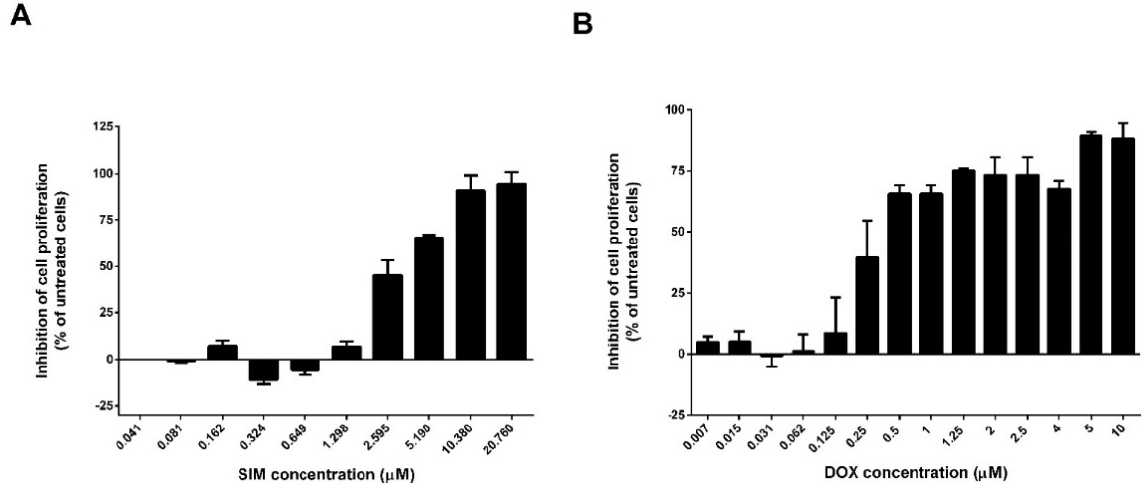
Figure 9. The effects of SIM and DOX on the proliferation of C26 murine colon carcinoma cells co-cultured with murine macrophages. The results show cell proliferation at 48 h after incubation of C26 murine colon carcinoma and murine macrophages, with 0.041–20.76 µ M SIM ( A ) or with 0.007–10 µ M DOX ( B ), as free forms. Data are presented as the mean ± standard deviation of triplicate measurements. The results are expressed as percentage of inhibition of co-cultured cells proliferation following SIM or DOX treatments, compared to the proliferation of control cells (untreated cells). Significance was considered at values of p < 0.05 (ns, p > 0.05; * p < 0.05; ** p < 0.01; *** p < 0.001; **** p < 0.0001).